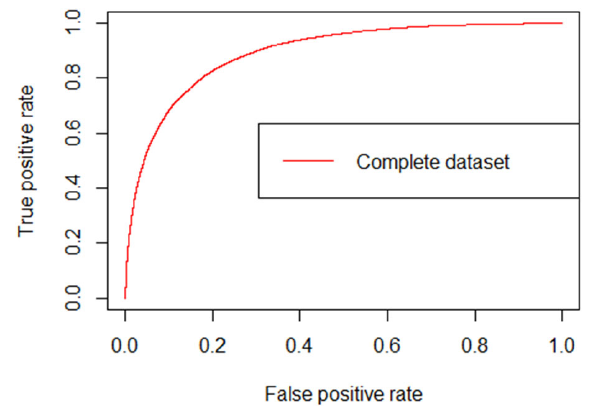
Figure 9. ROC curve complete dataset.